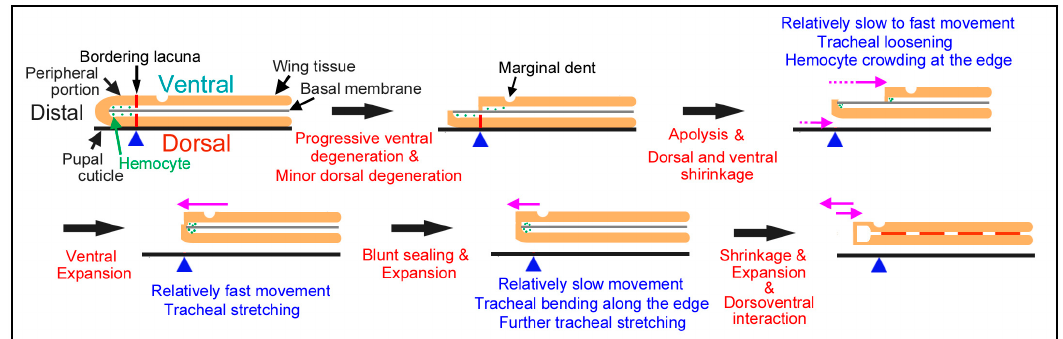
Figure 16. Schematic diagram for the peripheral adjustment of the pupal forewing. Possible changes are written in red and observations in the present study are in blue above or below illustrations. Directions of dynamic changes of epithelia are indicated by pink arrows. The locations of the bordering lacuna in the wing tissue are shown with red vertical bars and those in the pupal cuticle are with blue triangles, which serve as a guide spot, because it is safely assumed that the pupal cuticle does not move at all. Dorsoventral interaction is shown as horizontal orange bars between the ventral and dorsal epithelia. Dorsoventral interaction and blunt sealing are speculated (not observed here) based on the previous literature [37,38,42,43]. Cellular degradation is not confirmed in this study and, thus, is mostly speculative in this model. The coalescent edge of the two epithelia will be further degraded by programmed cell death (not shown in this diagram) [37–40].